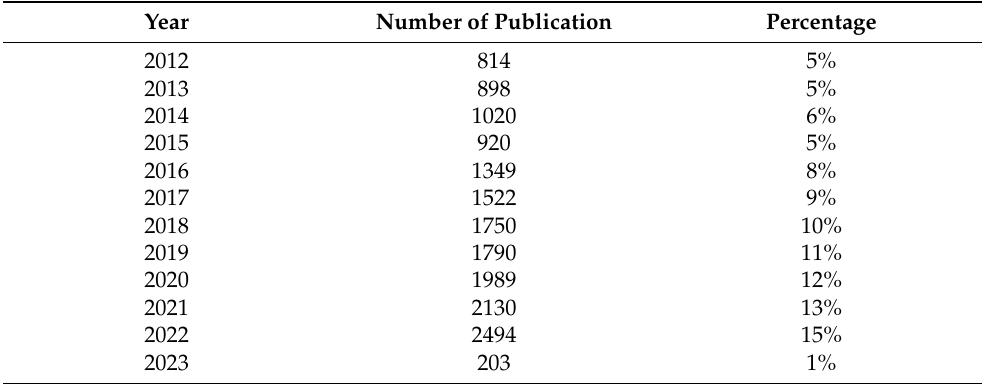
Table 1. Evolution of published articles on natural fiber per